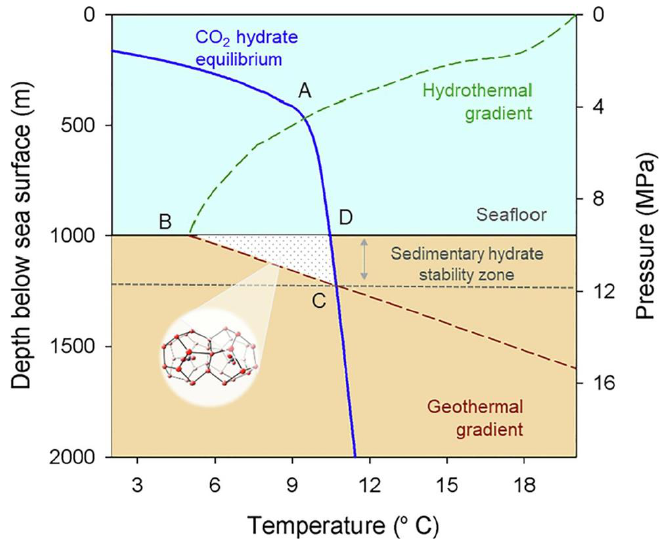
Figure 5. CO 2 hydrate stability zone [45].